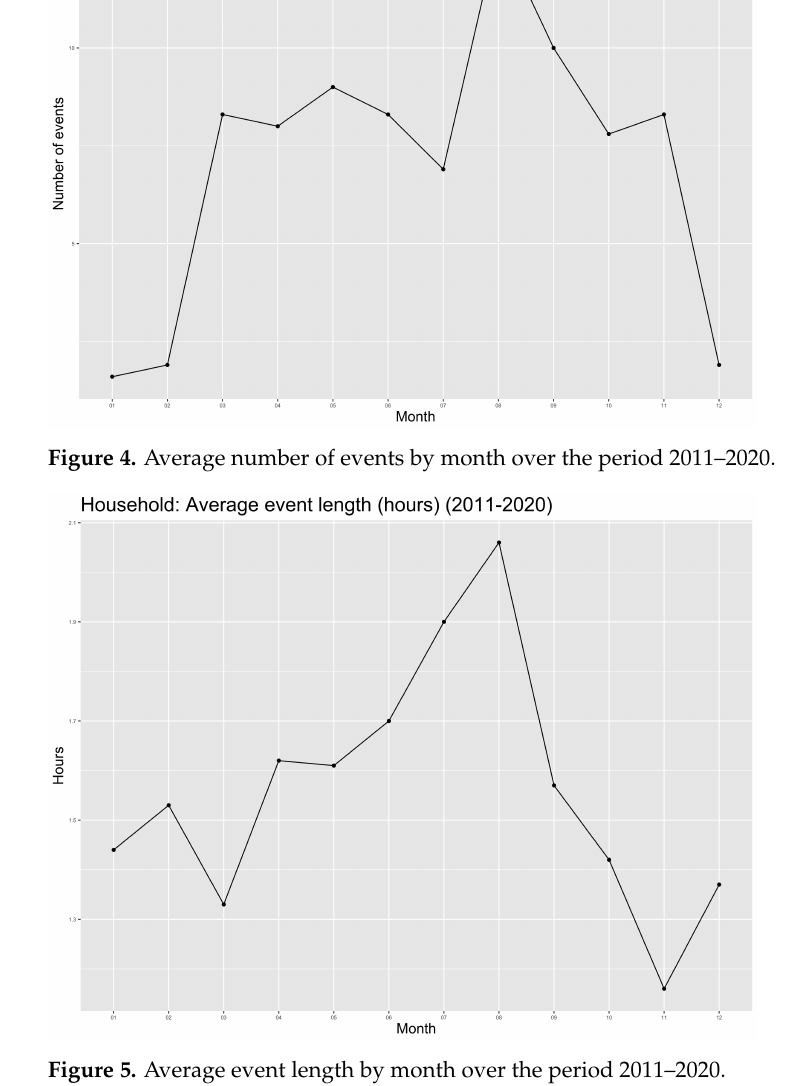
Figure 5. Average event length by month over the period